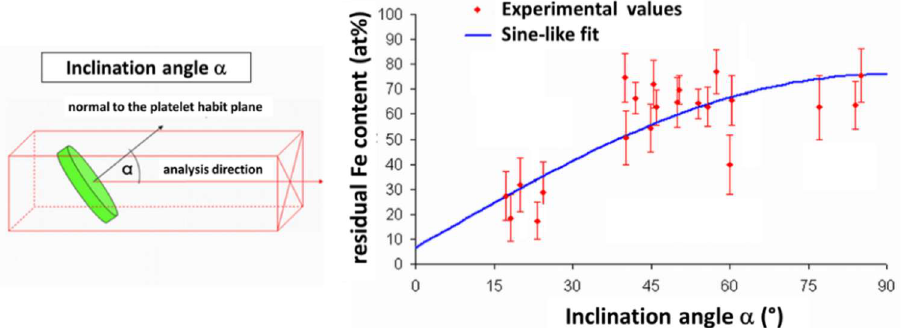
Figure 7. Measured Fe-concentration against the inclination angle between nitride and analysis direction.